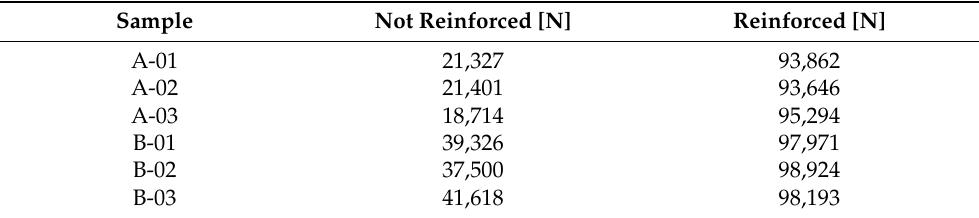
Figure 4. Characteristic section of the composite sample and structured mesh details inserted around the pin-hole in both advanced and simple configurations. Table 4. Experimental static failure load for different CFRP samples in initial and advanced configu- ration (A-i = solid laminate; B-i = sandwich